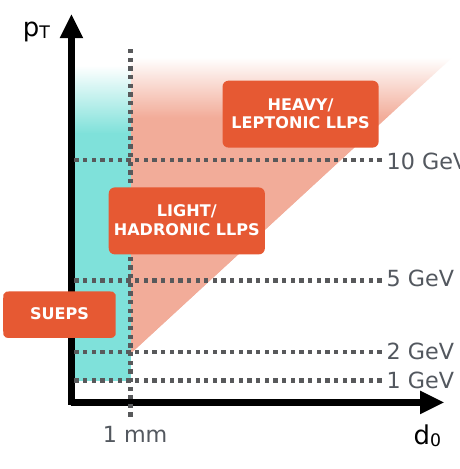
Figure 30. Recommended strategy for optimizing sensitivity to a large range of unconventional signals while minimizing resource usage. Teal represents prompt tracking, while orange repre- sents displaced tracking. HSCP sensitivity is not depicted, but relies on very accessible high- p prompt